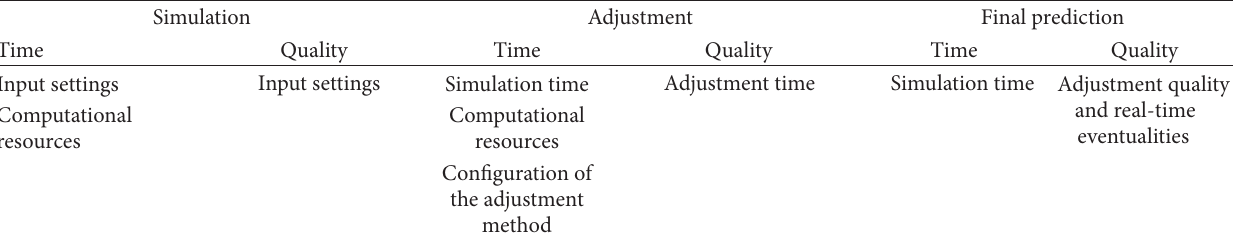
Table 1: Dependencies between each factor belonging to the two-stage prediction